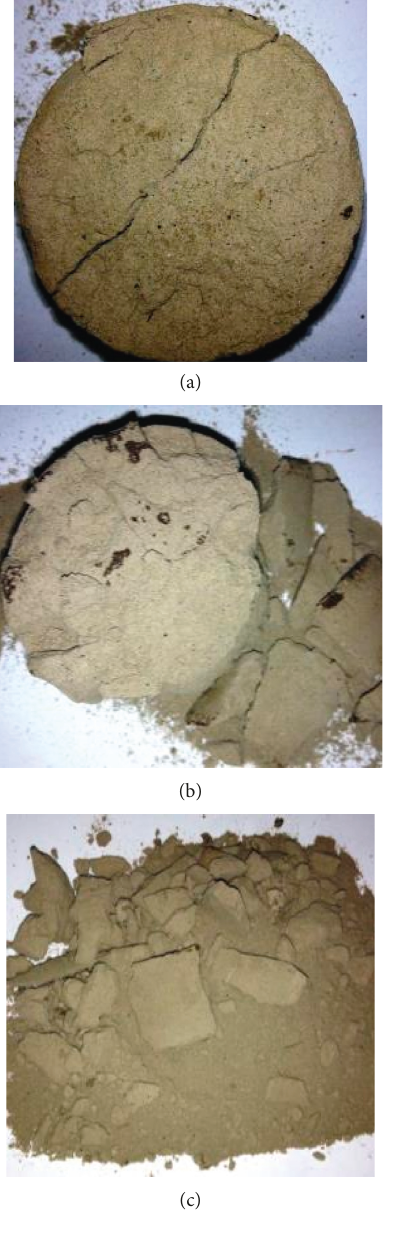
Figure 9: The failure mode of the specimen when _ ε � 56s − 1 . (a) Cement-sand ratio 1 :4. (b) Cement-sand ratio 1 :6. (c) Cement- sand ratio 1: